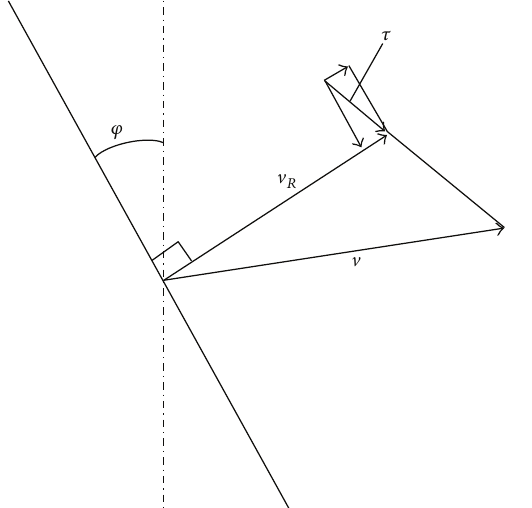
Figure 9: Gear coupling centrifugal force.